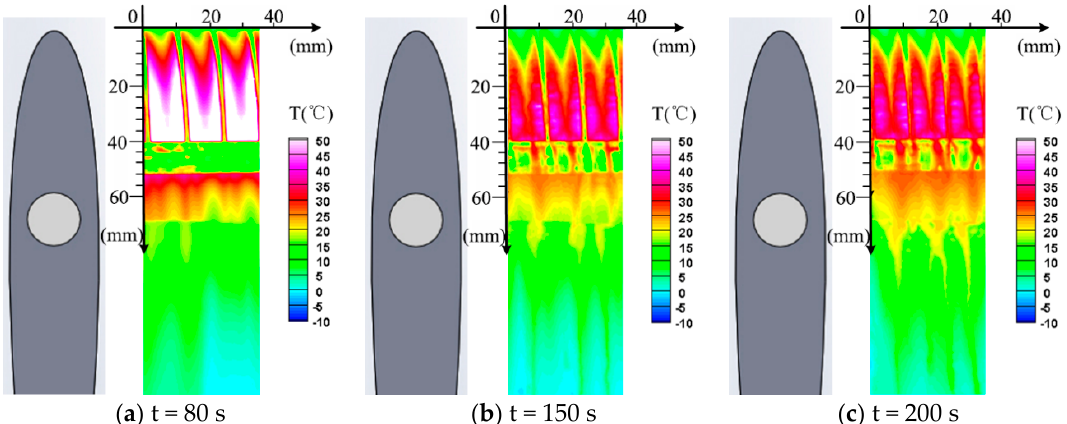
Figure 14. Time variation of the surface temperature distribution during the anti-icing process when applied with LV-HF discharge.